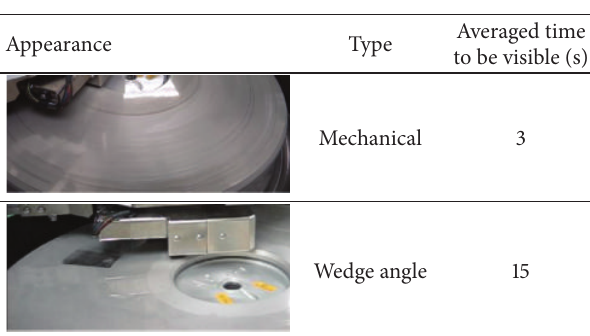
Table 4: Visible